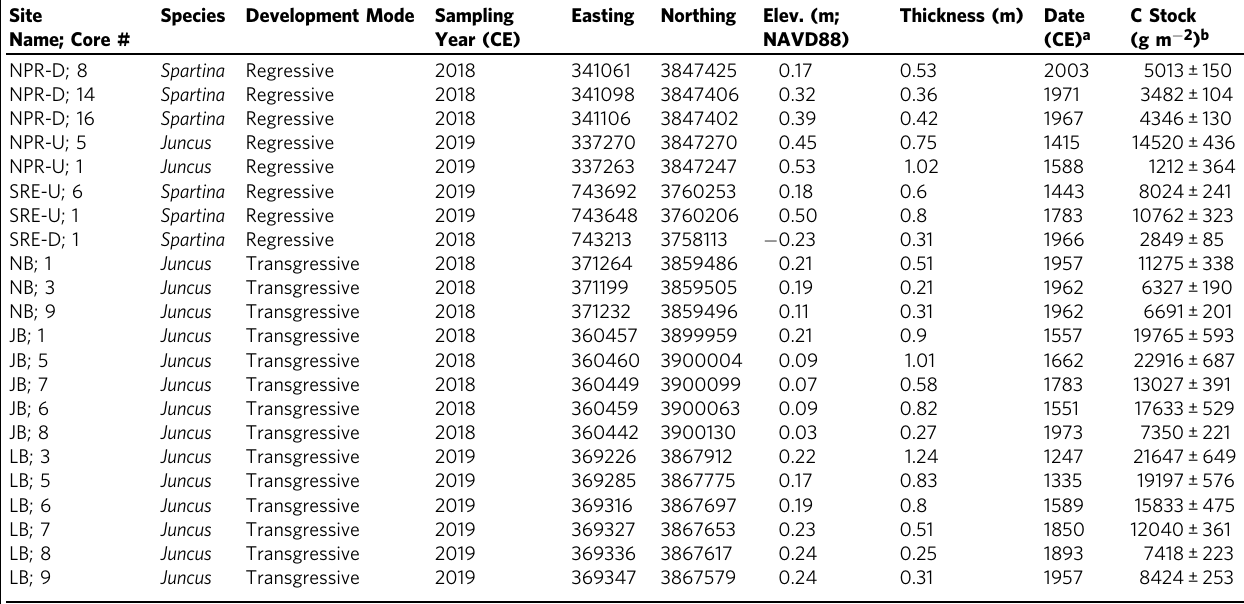
Table 1 Sampling site information and marsh sedimentary unit